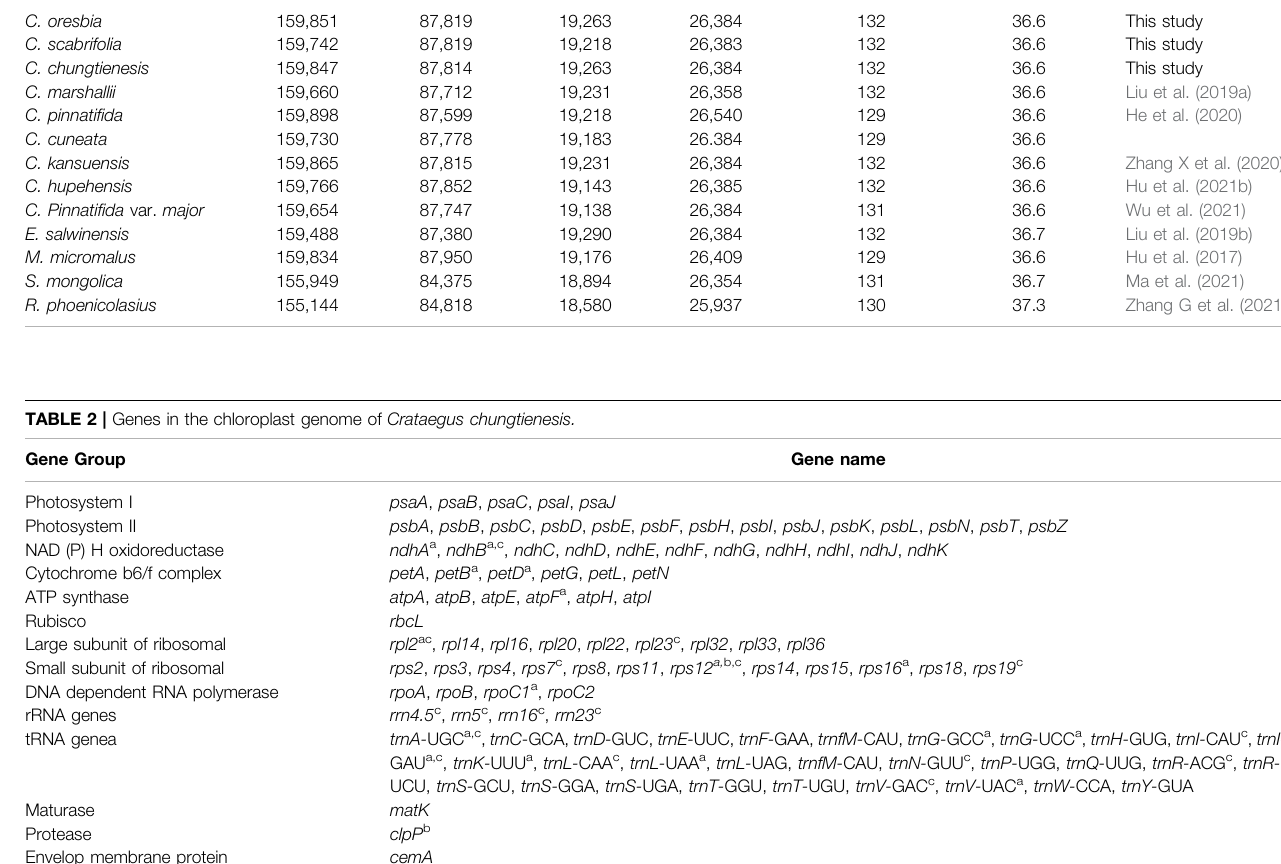
TABLE 1 | Comparison of chloroplast genome features of the nine species of Crataegus and four other genera of Rosaceae ( Eriobotrya , Malus , Rubus , and Spiraea ). Species